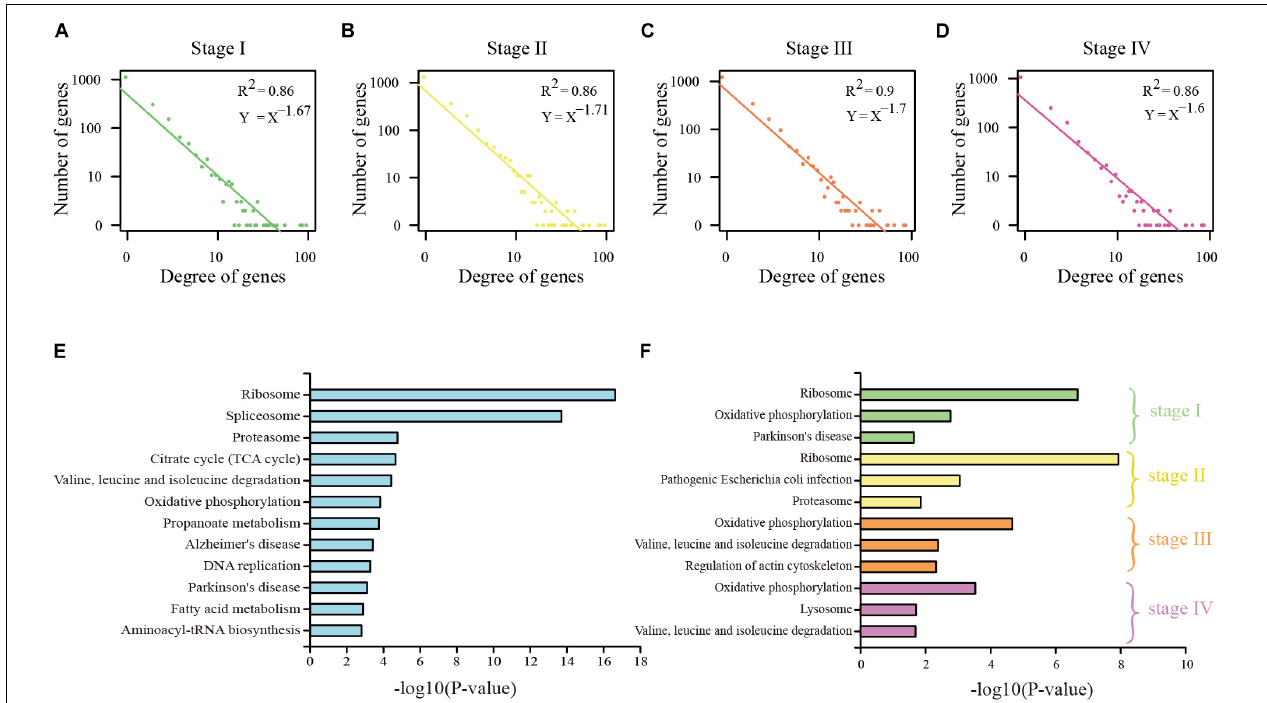
FIGURE 2 | Analysis of DEAG regulatory network in COAD. (A) The distribution of the degree of DEAG regulatory network in stage I. (B) The distribution of the degree of DEAG regulatory network in stage II. (C) The distribution of the degree of DEAG regulatory network in stage III. (D) The distribution of the degree of DEAG regulatory network in stage IV. (E) Significantly enriched KEGG pathways of common DEAGs. (F) Significantly enriched KEGG pathways of the DEAGs in every stage.